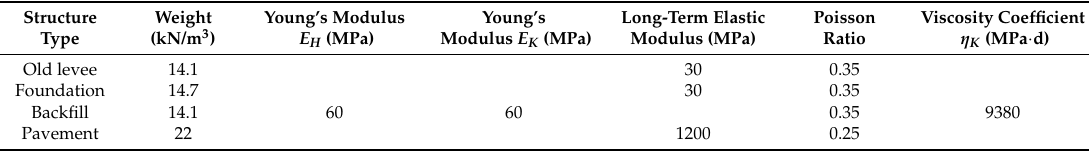
Table 2. Material parameters for calculation.